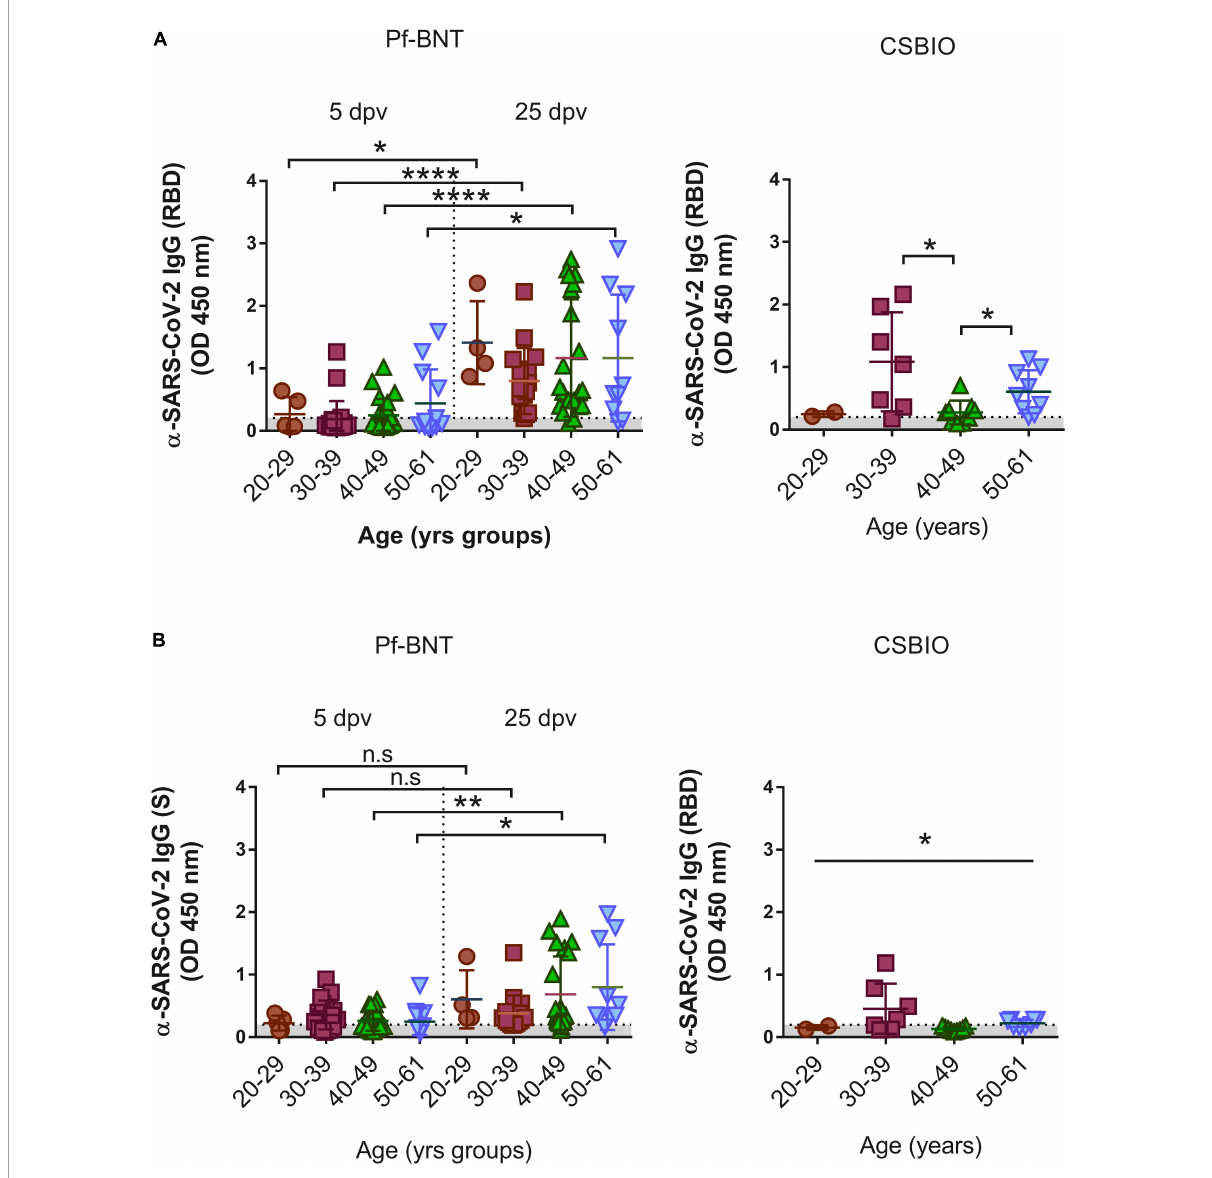
FIGURE2 IgG-specific responses to the SARS-CoV-2 RBD by age groups. IgG levels expressed as OD values against the (A) RBD and (B) S viral targets. A cut-off value > 0.20 (horizontal dotted line and gray zone , y axis) was used to define IgG positive or negative serum samples against SARS-CoV-2 RBD at four age groups, 20–29, 30–39, 40–49, and 50–61 ( x axis). Serum samples for Pf-BNT ( left panel ) and CSBIO ( right panel ) vaccinees were collected after 5 and 25 (separated by dotted line on x axis , left panel ), and 43 ( n = 27) dpv, respectively [vaccine values separated by vertical dotted line ( x -axis)]. Mann–Whitney test: **** p < 0.0001; p < 0.001; * p < 0.05. One-way ANOVA ( p < 0.05). n.s., no significant differences. Each group of data in the scatter plots represent absorbance values (OD) obtained from individual serum sample per vaccine group including the mean ± SEM (standard error) of individual